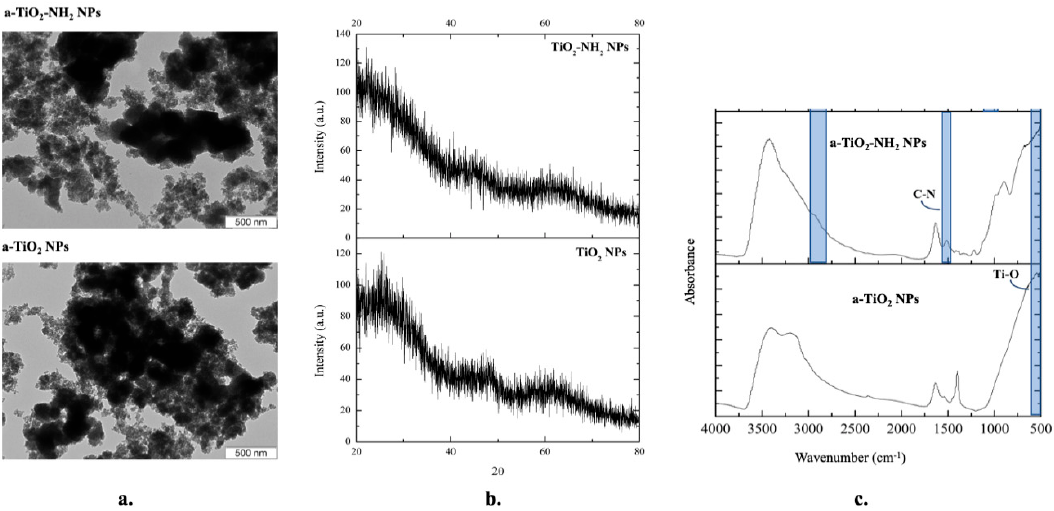
Figure 1. Physical characterization of amorphous TiO 2 (a-TiO 2 ) (lower panels) and a-TiO 2 -NH 2 nanoparticles (NPs) (upper panels): ( a ) TEM images, ( b ) X-ray diffractograms, and ( c ) FTIR spectra.